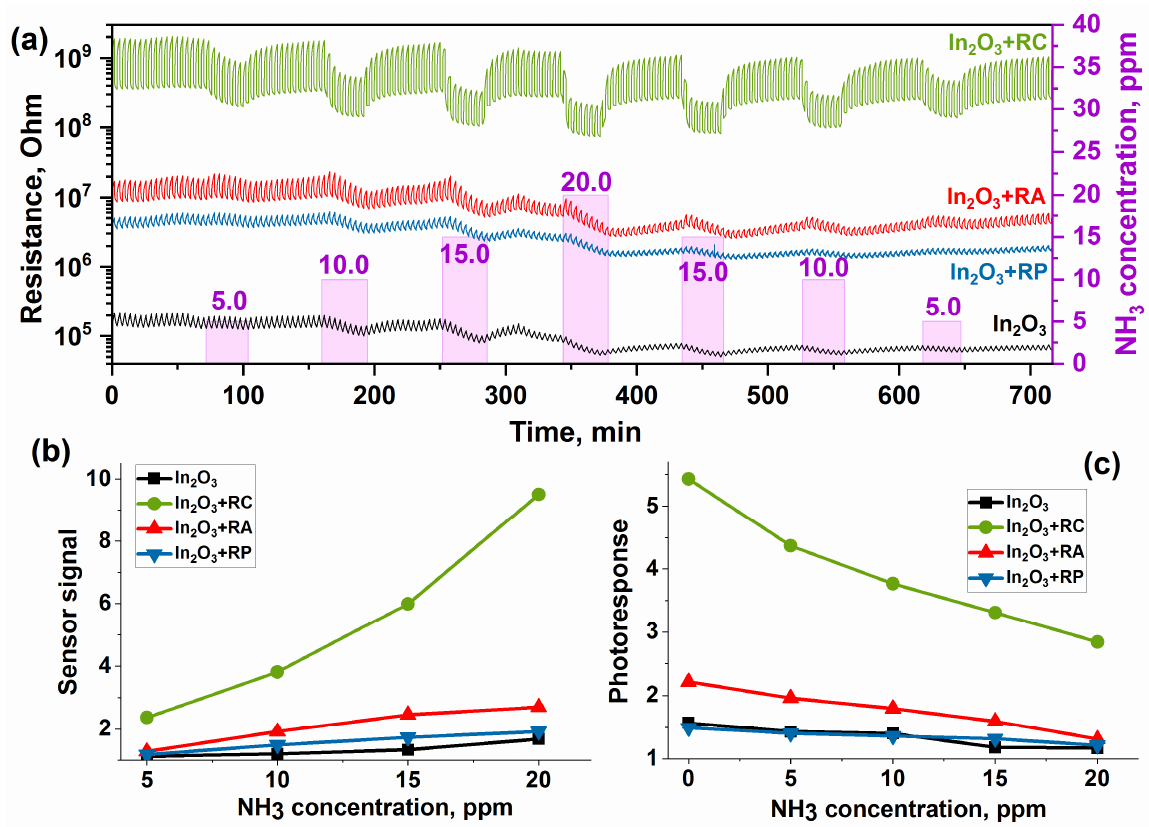
Figure 6. Change in resistance ( a ), correlation of the sensor signal ( b ), and photoresponse ( c ) versus NH 3 concentration of samples.